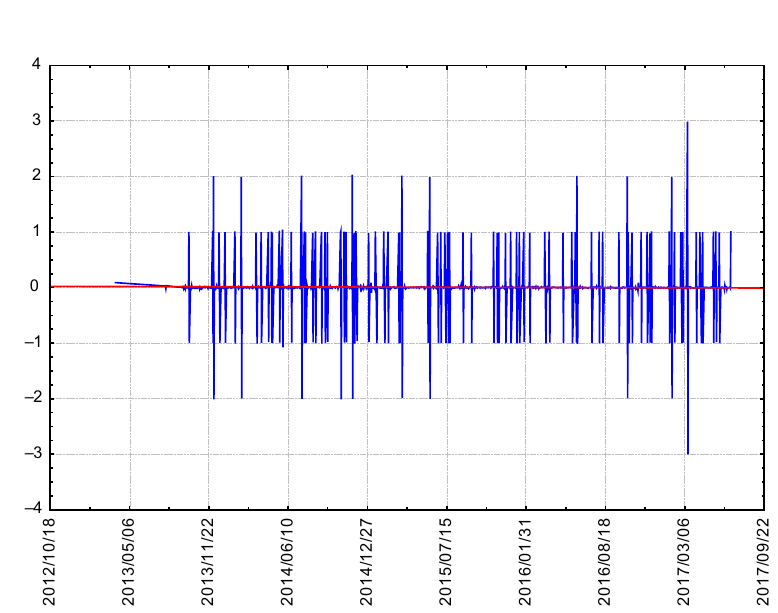
Figure 2. The conditional volatilities of the crude oil WTI futures in the presence of OPEC news over the period from April 01,